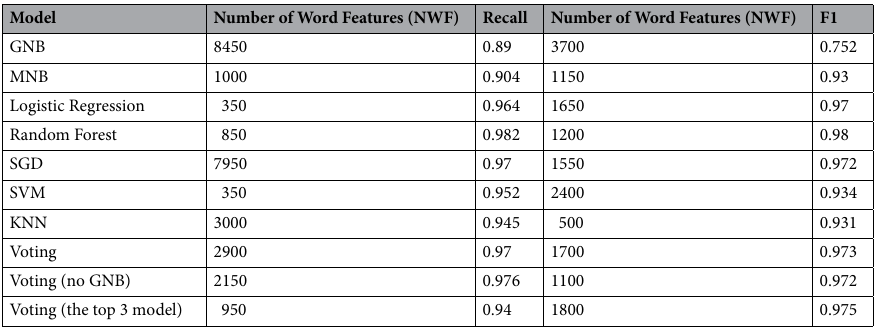
Table 4. Prediction results for individual classifier algorithms. GNB, Gaussian naïve Bayes; MNB, multinomial naïve Bayes; SGD, stochastic gradient descent; SVM, support vector machine; KNN, K-nearest